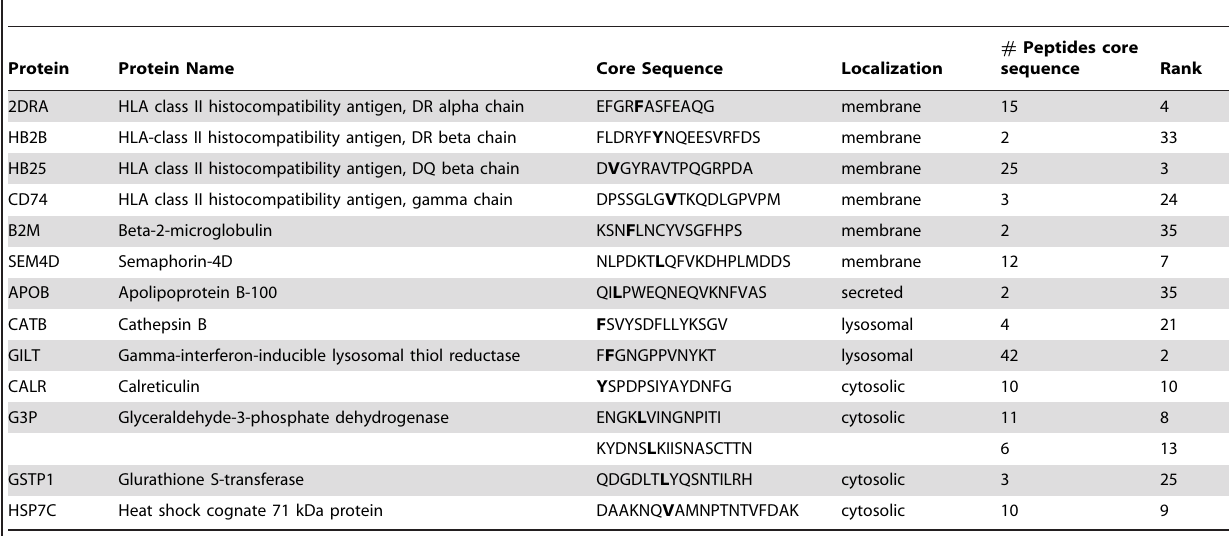
Table 2. Core sequence of a subset of abundant self-peptides isolated from both T cells and B cells (donor 1).